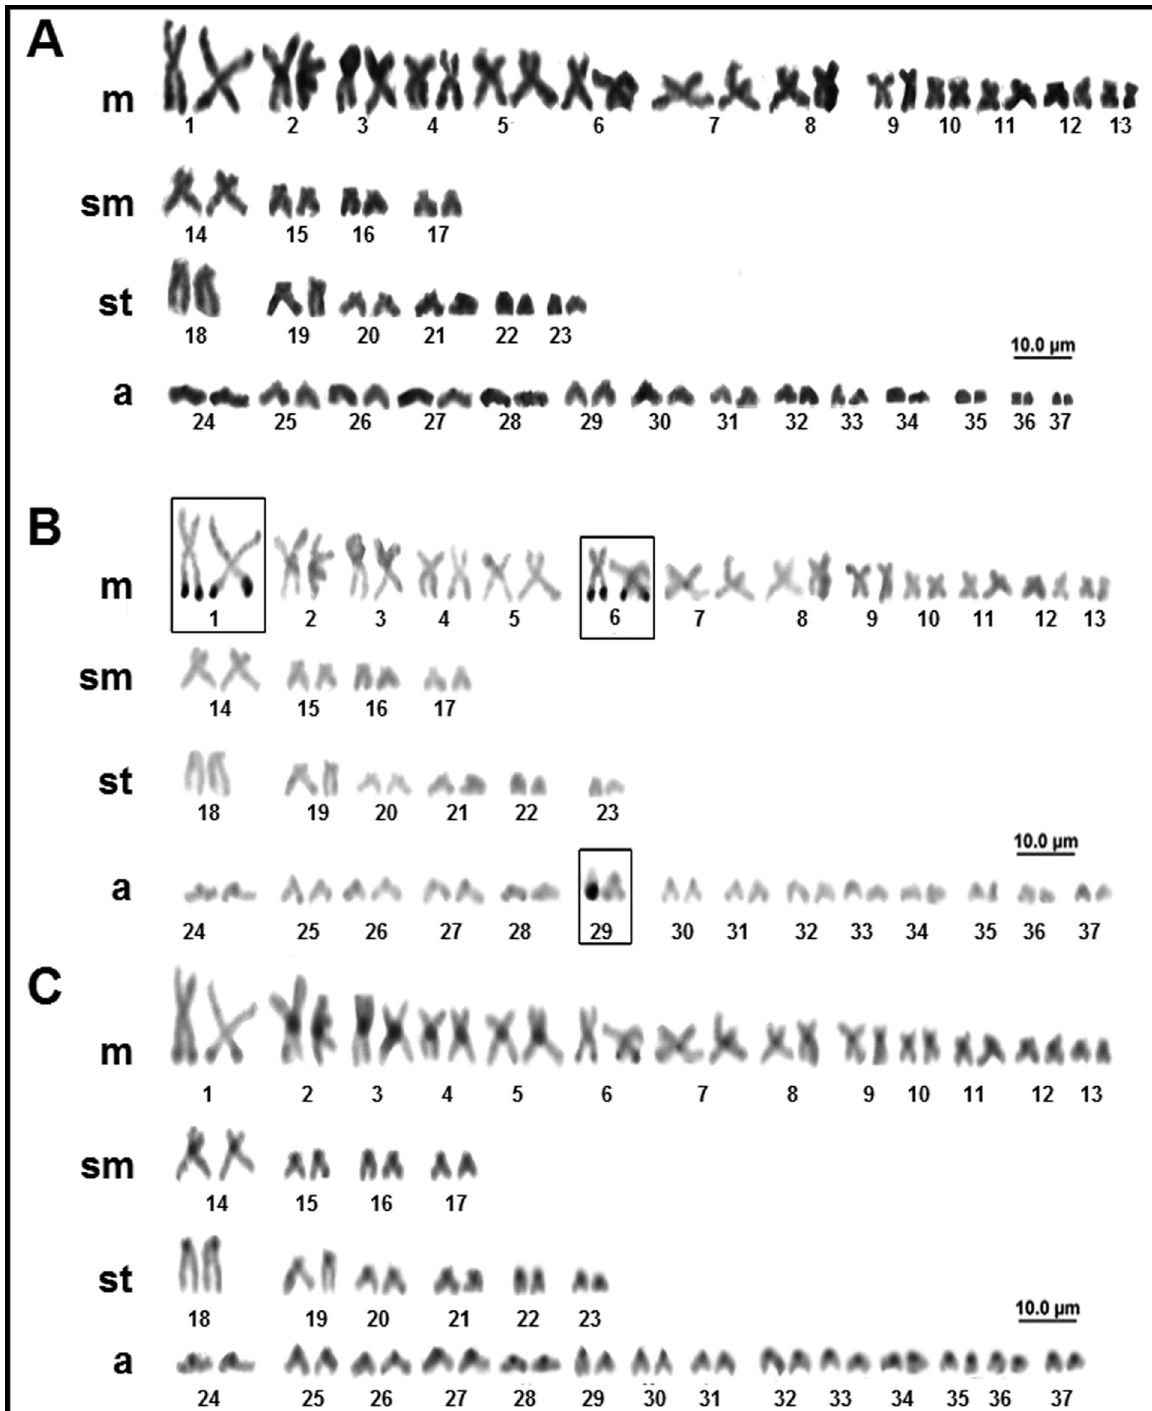
Figure 2 - Karyotype of Plesiotrygon iwamae : (A) conventional Giemsa staining; (B) sequential AgNO 3 ; (C) sequential